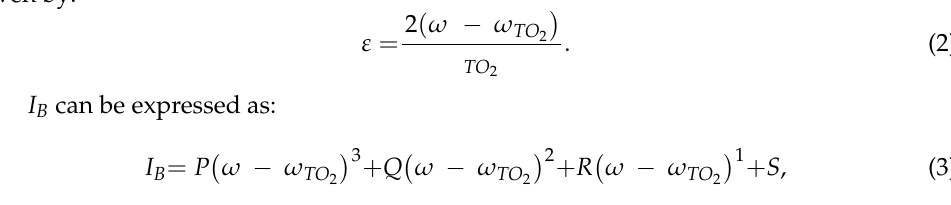
method. The other three intensity-type channels are all defined as the ratios to eliminate the influence of absolute intensity change exhibited by the first channel. The second channel represents the relative Fano resonance depth and is defined as the intensity ratio of the TO 2 modes peak at 201 cm −1 and the valley at 191 cm −1 . At the same time, the third channel is defined as the intensity ratio of the TO 3 modes peak at 278 cm −1 and the neighboring spectrum at 268 cm −1 . The fourth channel is defined as the intensity ratio of the TO 4 modes peak at 543 cm −1 and the second-order TO 4 + TA mode at 570 cm −1 . The fifth and sixth channels represent the peak positions of the TO 2 modes and the TO 3 modes, respectively. In contrast, the seventh channel is defined as the position of the higher peak between the TO 4 modes and the TO 4 + TA mode. The corresponding results are illustrated in Figure 3, and these patterns can confirm the aforesaid analyses of the Raman spectrum variations. Moreover, several new phenomena emerge: the surround- ing areas present opposite variation tendencies for both the intensity and the peak posi- tion compared to the femtosecond laser processed track regions, as exhibited in Figure 3b,d,g; the peak redshifts (i.e., wavenumber increase) of the TO 2 modes and TO 3 modes, as shown in Figure 3e,f.